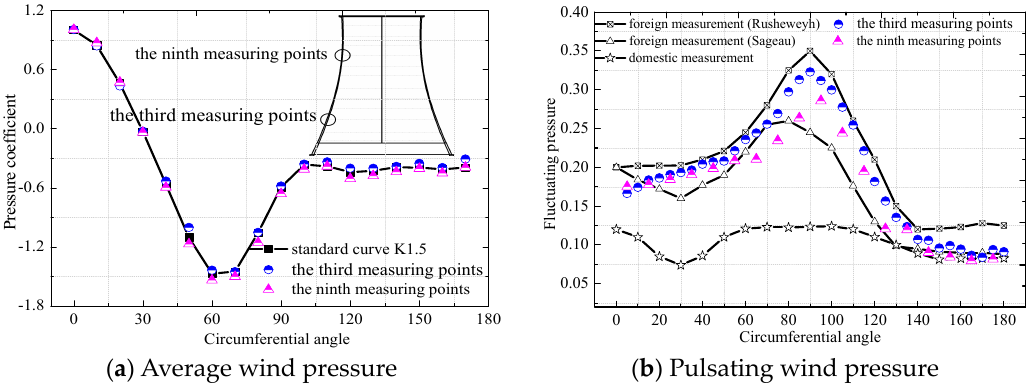
Figure 2. Comparison of numerical calculation, field measurement, and wind tunnel test.